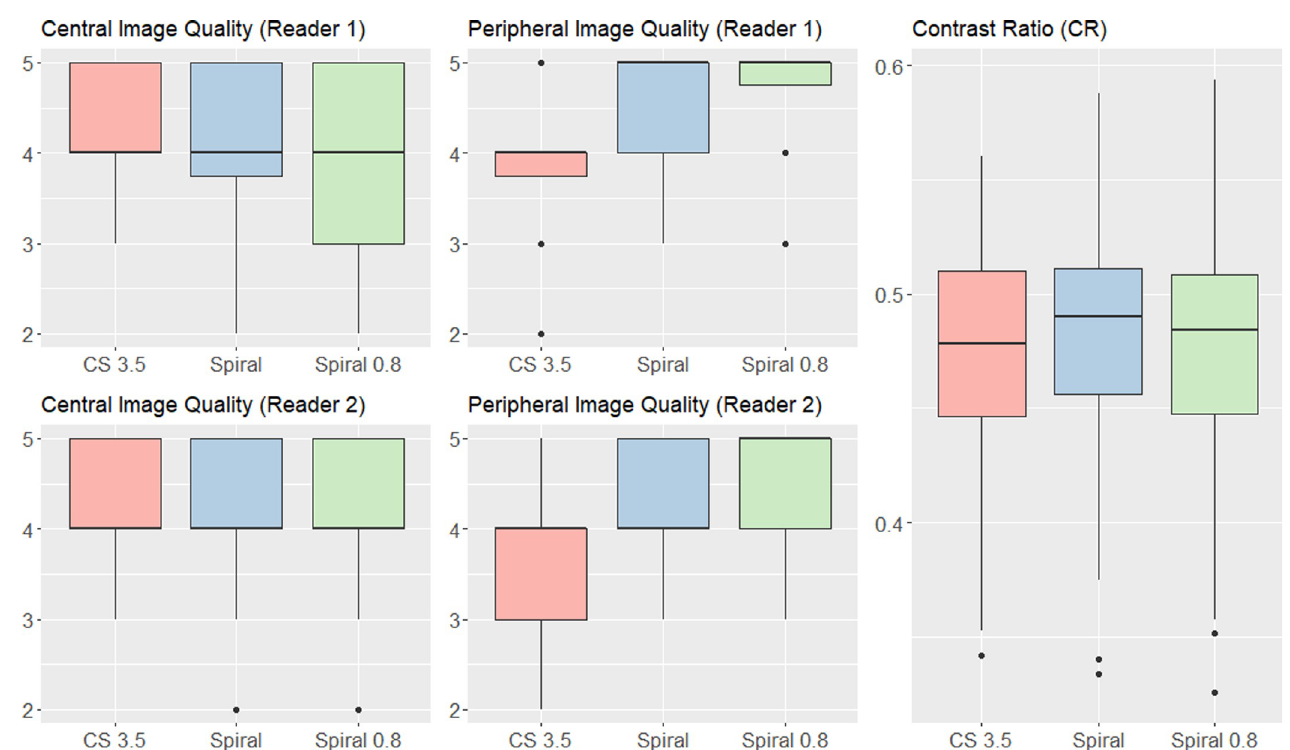
Fig 1. Visualization of the data from qualitative and quantitative image quality assessment. The data is depicted with boxplots. The prominent black lines within the boxplots represent the medians. The hinges of the boxplots mark the 25 th and 75 th percentiles. The upper/ lower whiskers extend from the hinges to the largest/smallest value no further than 1.5 � Interquartile Range from the